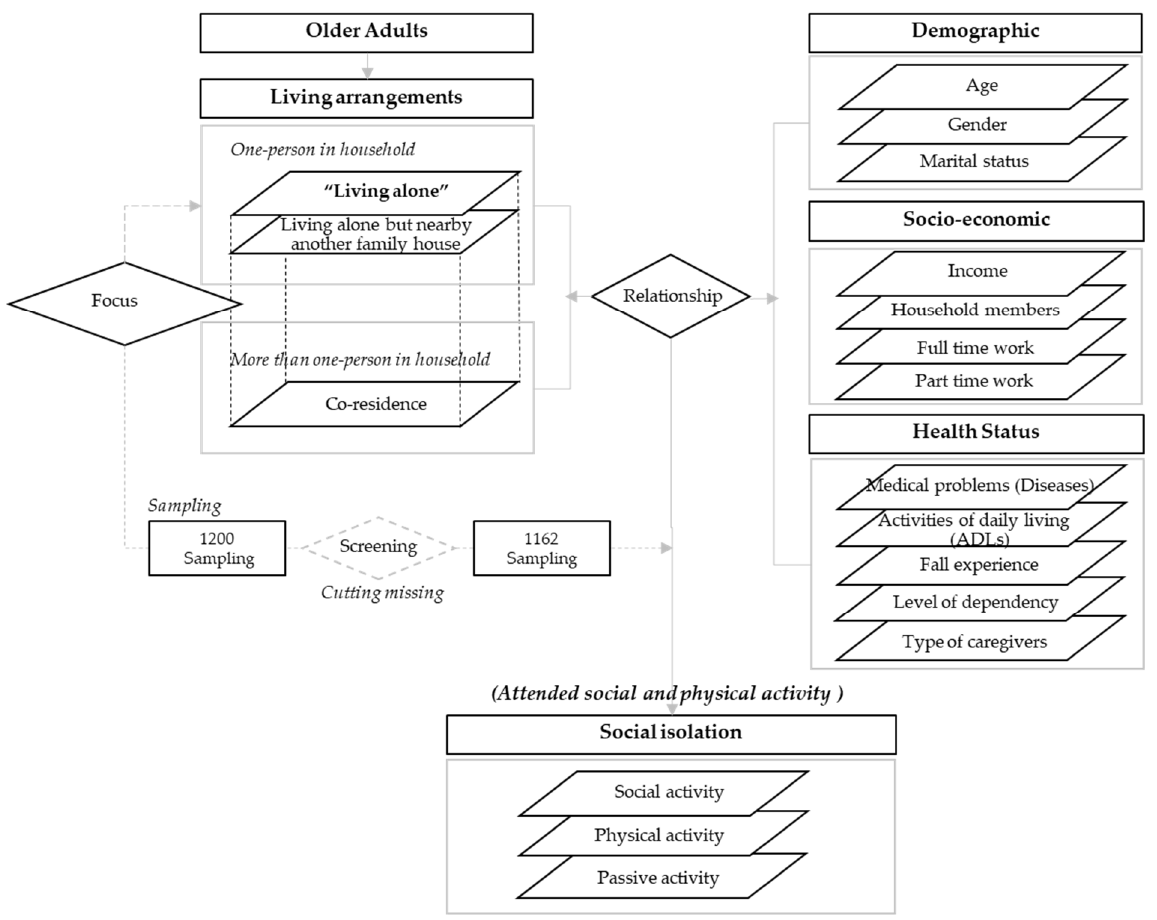
Figure 2. Framework of study .